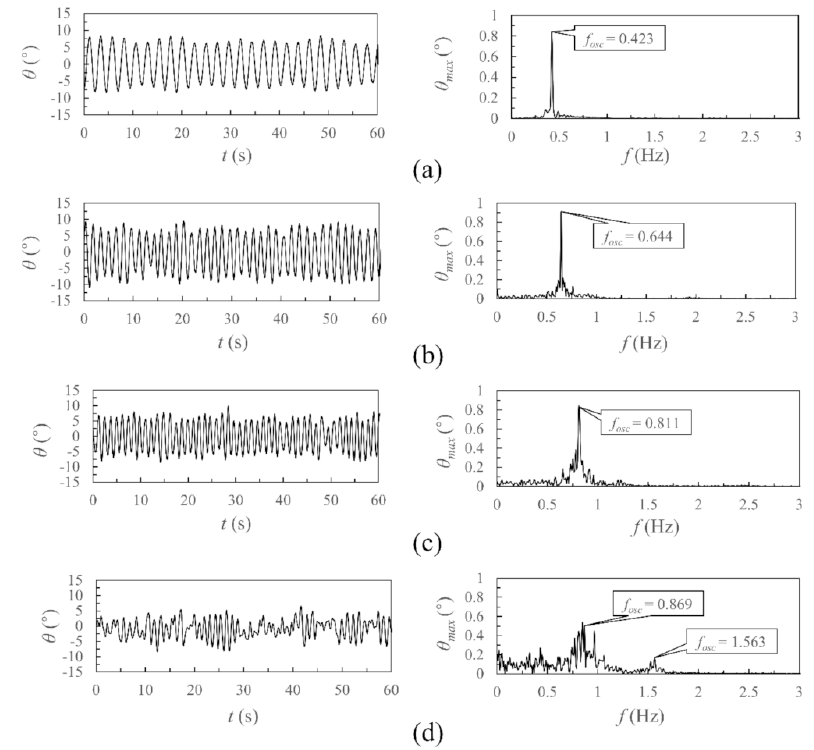
Figure 21. Rotational oscillation time history and spectral characteristics at L / D = 9.0: ( a ) U = 0.265 m/s ( U r = 3.499); ( b ) U = 0.483 m/s ( U r = 6.372); ( c ) U = 0.628 m/s ( U r =